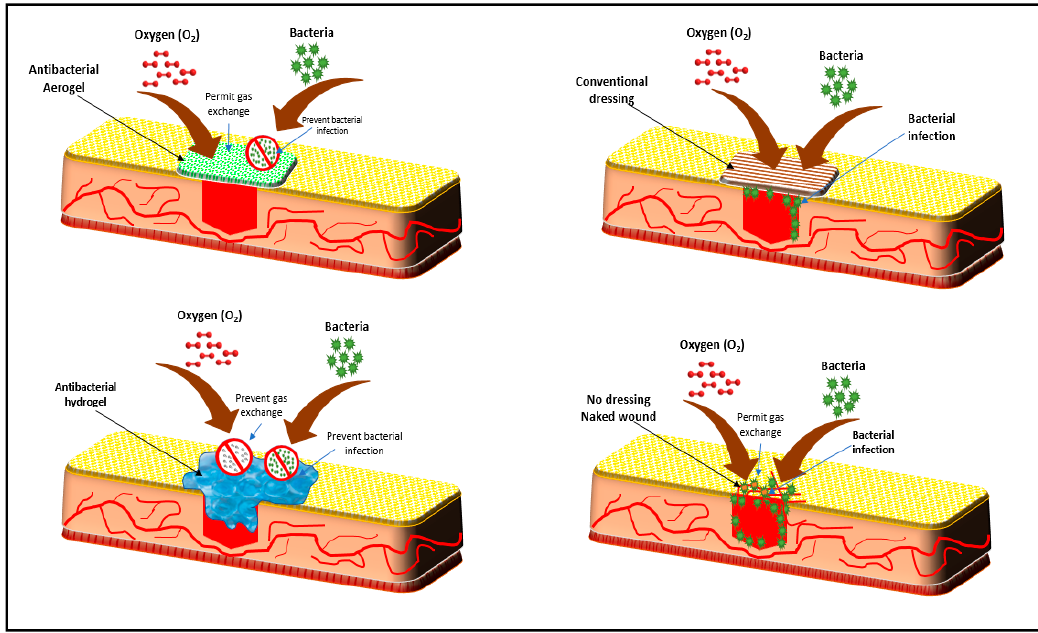
Figure 7. Schematic drawing of conventional dressing materials and antibacterial aerogel.